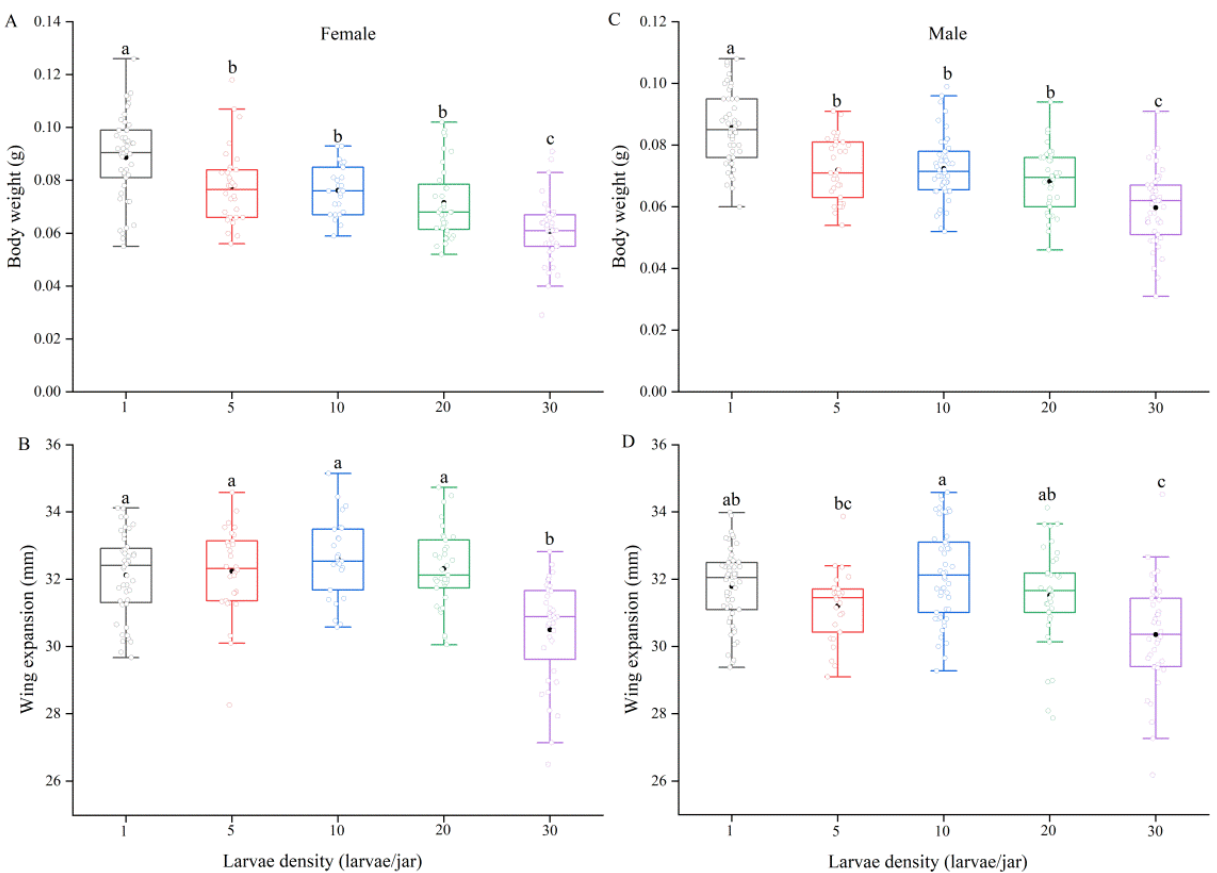
Figure 2. Body weight ( A : females, C : males) and wing expansion ( B : females, D : males) of Spodoptera frugiperda under different larval densities. Solid black bars represent the maximum line, median line and minimum line (from top to bottom in each boxplot). Boxplots display a mean dot, IQR boxes, 1.5*IQR whiskers and observed values (open circle). Different lowercase letters above group bars indica te significant differences among different larvae densities by Tukey’s HSD test at the 5% level. Sample sizes for body weight (left to right) were 50, 34, 27, 36 and 38 females, and 51, 33, 52, 38 and 47 males, respectively. Sample sizes for wing expansion were 44, 30, 27, 35 and 36 females, and 53, 27, 50, 37 and 38 males, respectively.